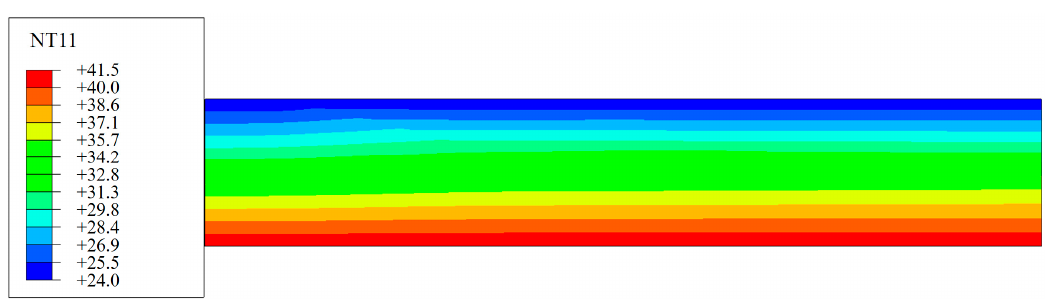
Figure 8. Temperature field of bedrock with a water level of 370 m before impoundment (unit: °C).